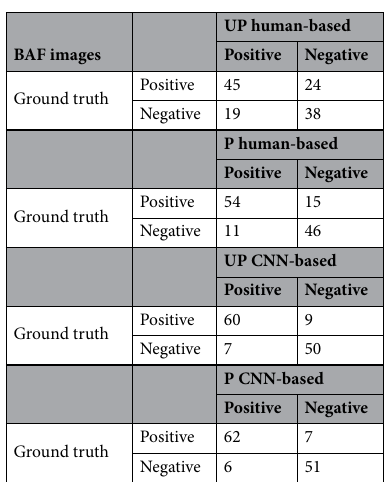
Table 1. Classification matrices describing the performances on BAF images of human-based methods on both unprocessed (UP) and processed (P) images and CNN-based methods on both UP and P images. BAF blue autofluorescence, CNN convolutional neural